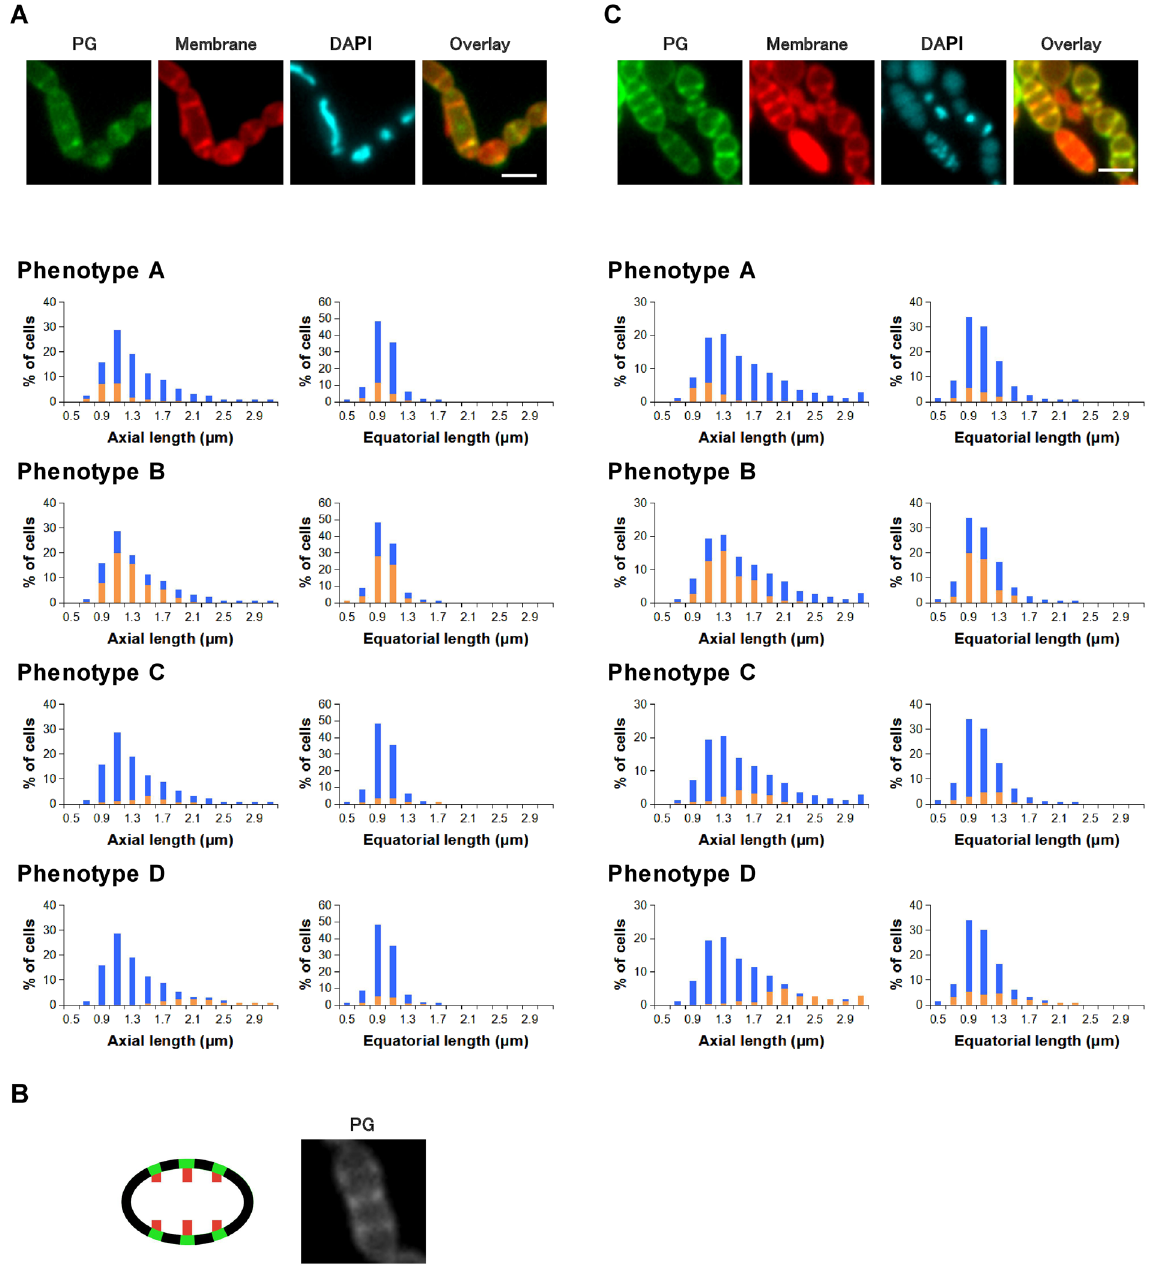
Figure 7. Average distributions of cell sizes and phenotypes of chlorobiphenyl vancomycin (0.25 μ g/mL)- treated Streptococcus pyogenes ( A , B ) and des- N- methylleucyl chlorobiphenyl vancomycin ( Δ NCBPV) (3 μ g/mL)-treated S . pyogenes ( C ) (n = 3). ( A and C ) Typical fluorescent images and cell size distribution of phenotypes A–D ′ . Images: PG (growing peptidoglycan stained using the sortase method), Membrane (Nile red staining), DNA (DAPI), and Overlay (overlay of PG and Membrane images); scale bar: 2 μ m. Blue bars in histograms represent the cell size distribution of all cells. Orange bars in histograms represent the size distribution cells with the indicated phenotypes. Statistical analysis regarding the histograms is available in Supplementary Table S6. ( B ) Schematic drawing and labeled PG image of phenotype D ′